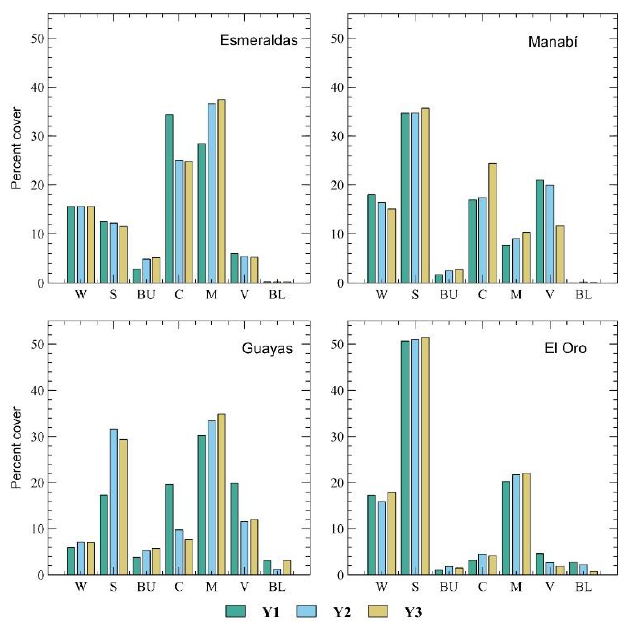
Figure 4. Percent cover of each LULC type by province during Y1, Y2, and Y3 (see Table 3). LULC